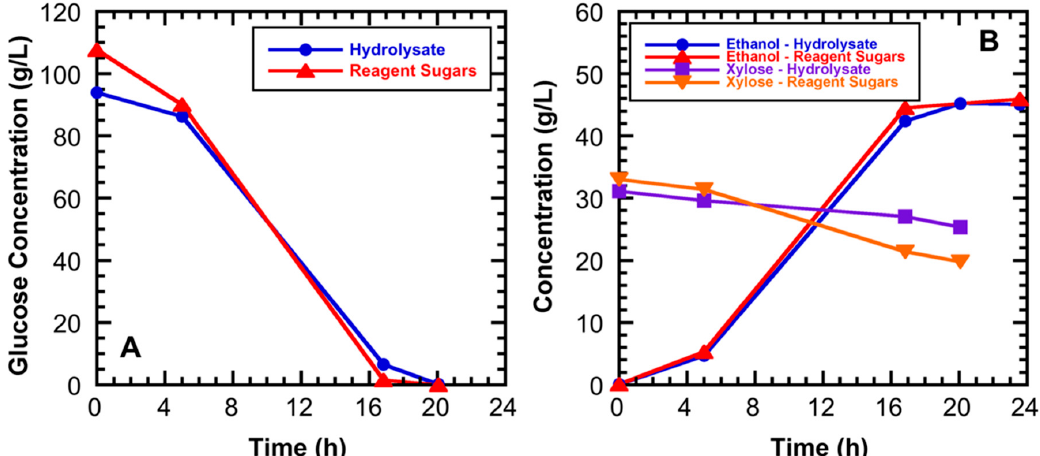
Figure 4. Comparison of fermentation efficiency and kinetics for sugarcane bagasse hydrolysate and reagent-grade sugar fermentations by S. pastorianus . ( A ) Glucose ( (cid:8) , (cid:78) ); ( B ) ethanol ( (cid:8) , (cid:78) ) and xylose ( (cid:4) , (cid:72) ). The hydrolysate concentration was 123 g / L glucose and 44 g / L xylose, which resulted in fermentation media of approximately 94 g / L glucose and 31 g / L xylose. Cultures in sugarcane bagasse hydrolysate (Hydrolysate; (cid:8) , (cid:4) ). Cultures in reagent-grade sugars (Reagent Sugars; (cid:78) , (cid:72) ). These two conditions were each conducted as singletons.